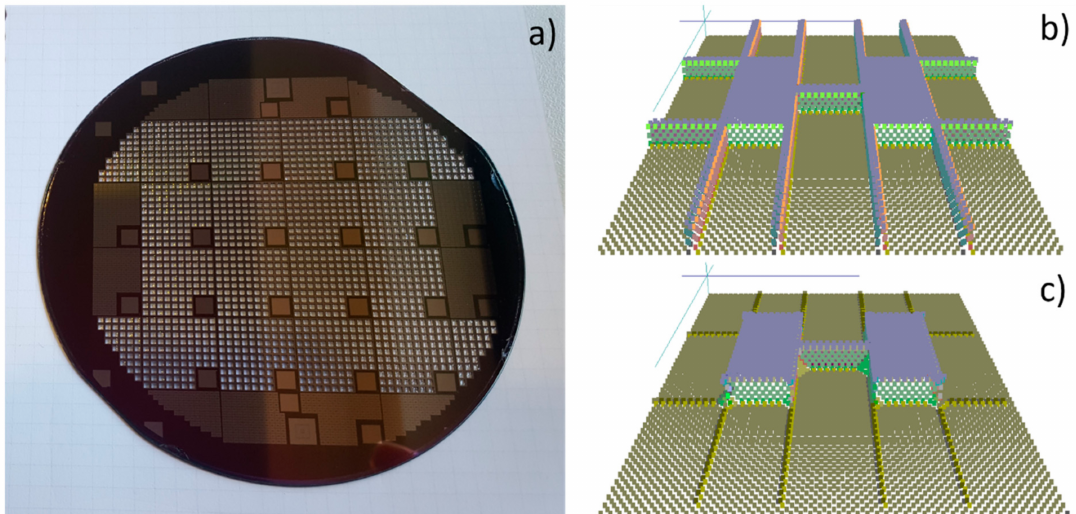
Figure 3. ( a ) SOI wafer after the final back-side dry etching to suspend the platforms. ( b ) Wet etching simulation of silicon in KOH solution for the proposed microdevices after the final dry etching. Initial geometry before wet etching. ( c ) Simulated results for the geometry after 20 min. in KOH-based